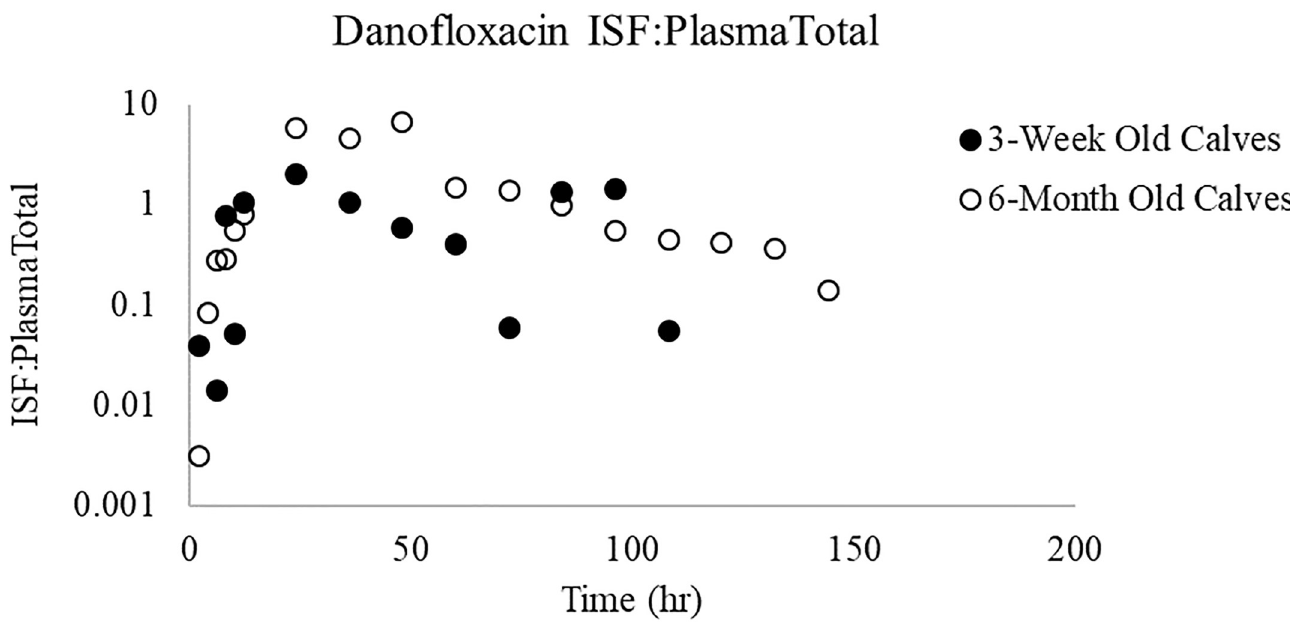
Fig 2. ISF:Plasma Total ratios for danofloxacin. Ratios comparing unbound drug in ISF to total drug (bound and unbound) in plasma.